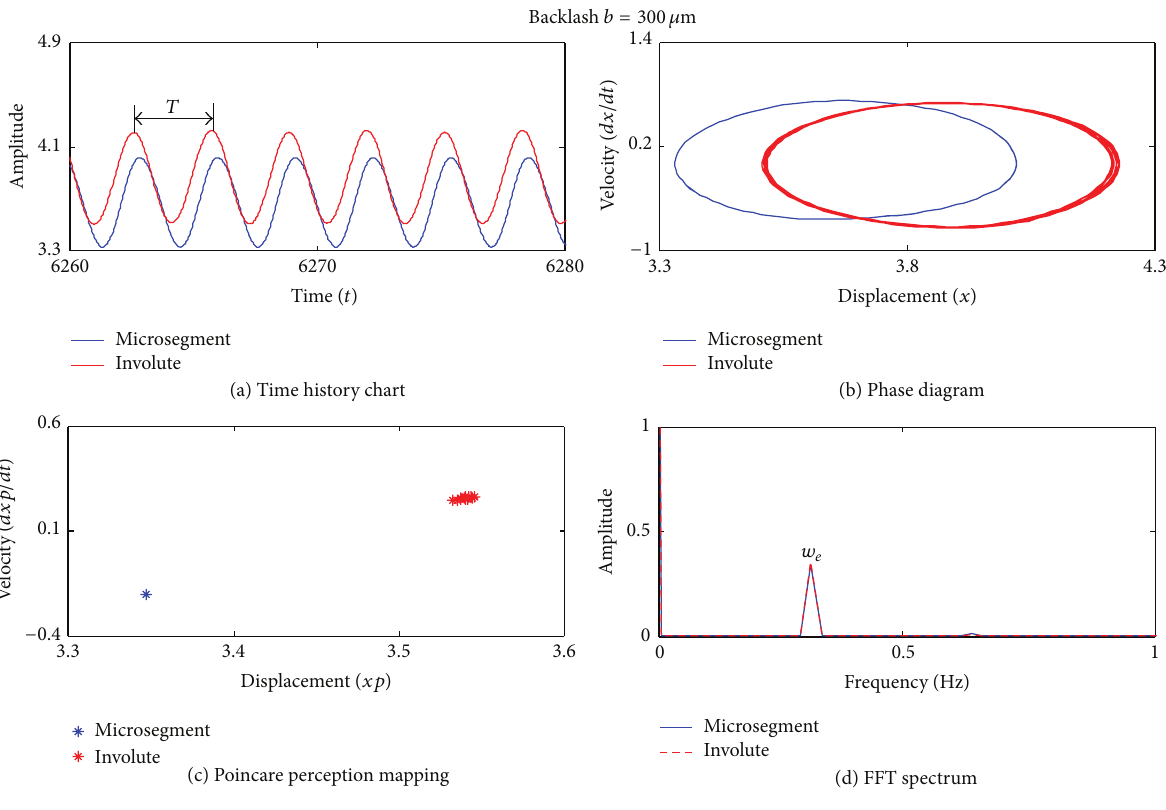
Figure 9: Dynamic performance comparison at Ω = 2 , 𝑇 = 1000 N ⋅ m.